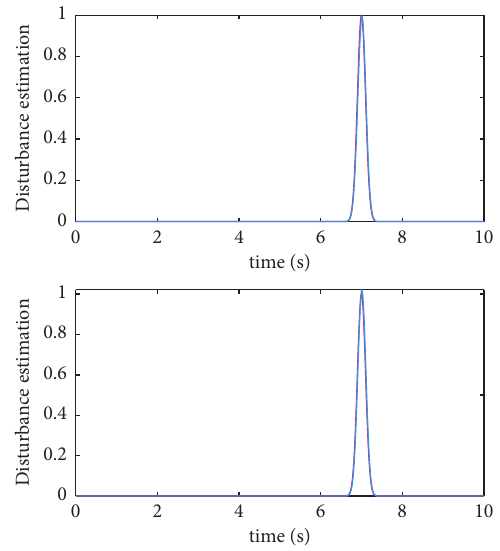
Figure 8: Disturbance estimation.